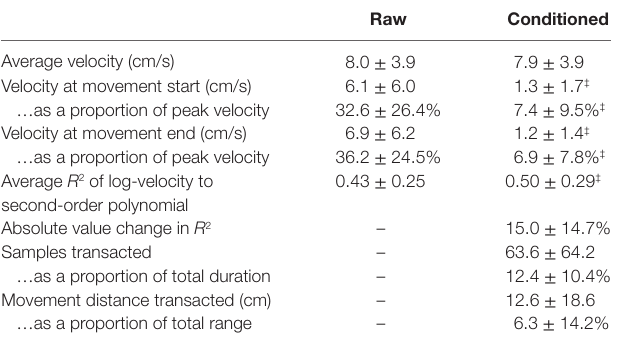
tABLe 1 | Summary statistics for before and after file reapportionment.